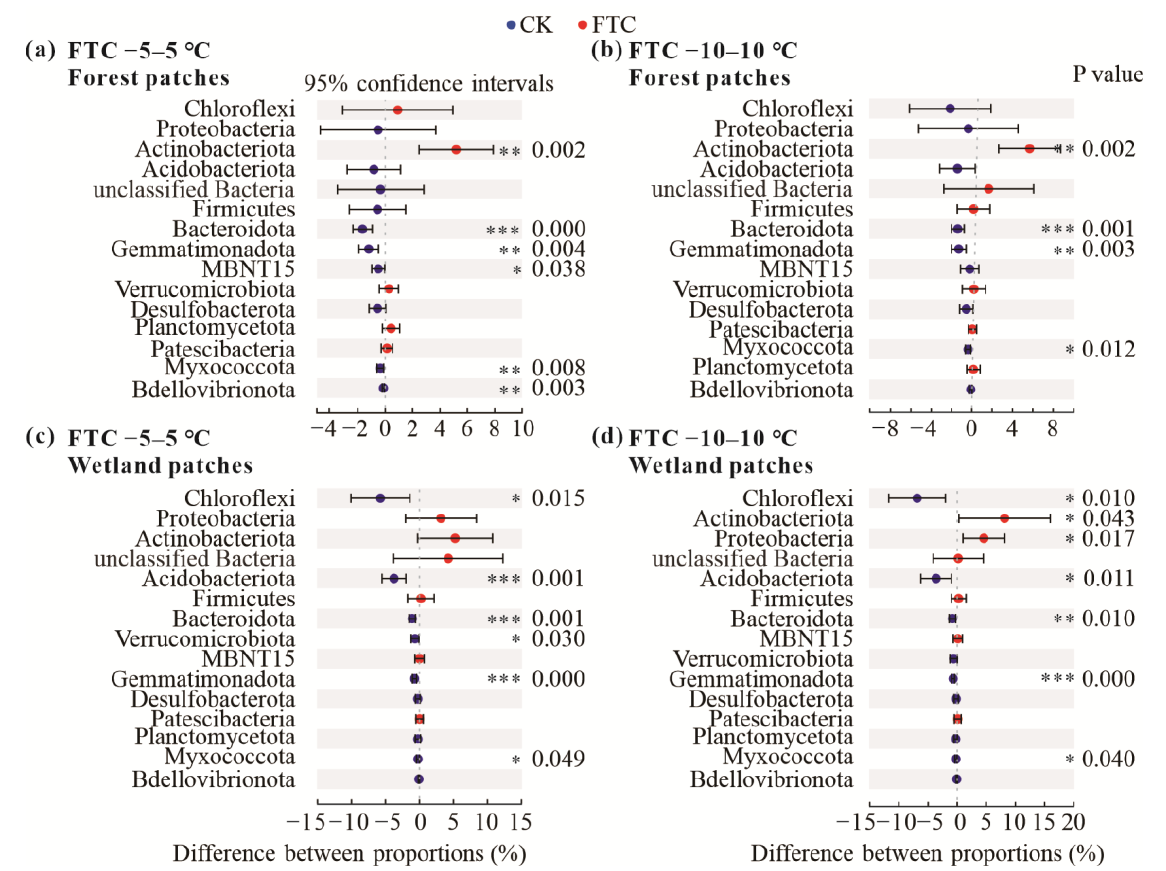
Figure 4. Differences in relative abundance of phyla (top 15) between preincubation and FTCs treatments (average of the 1st, 3rd, and 9th FTCs). ( a ) forest patches, − 5 – 5 °C FTC treatment; ( b ) forest patches, − 10 – 10 °C FTC treatment; ( c ) wetland patches, − 5 – 5 °C FTC treatment; ( d ) wetland patches, − 10 – 10 °C FTC treatment. Data are shown as the difference in proportions. * indicates p < 0.05; ** indicates p < 0.01; *** indicates p < 0.001.